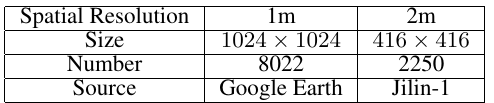
Table 1. The information of the training